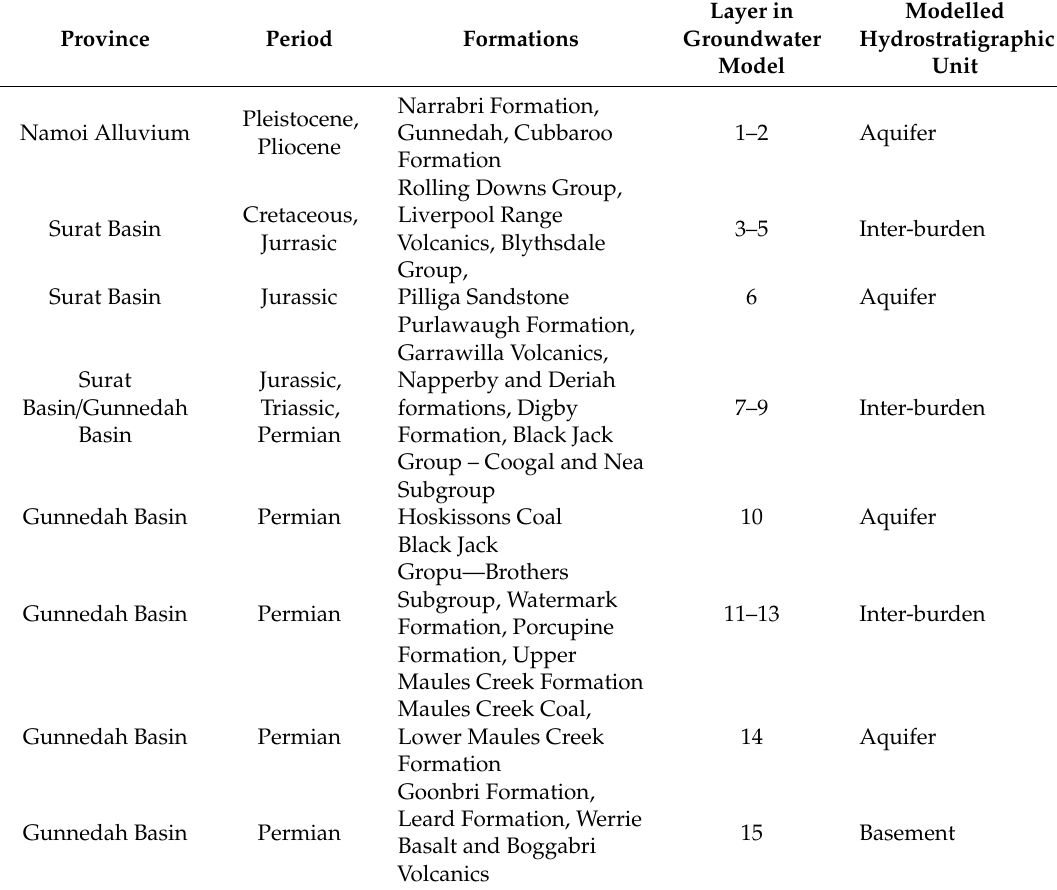
Table 2. Conceptualization of hydrostratigraphy and layers in the numerical groundwater